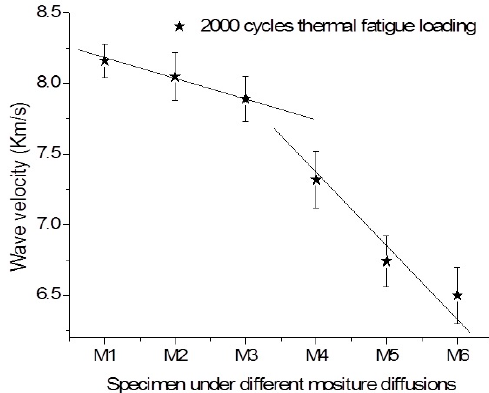
Figure 7. Variation of wave velocity in the specimen, which subjected 1000 cycles thermal fatigue, in different moisture diffusional states.